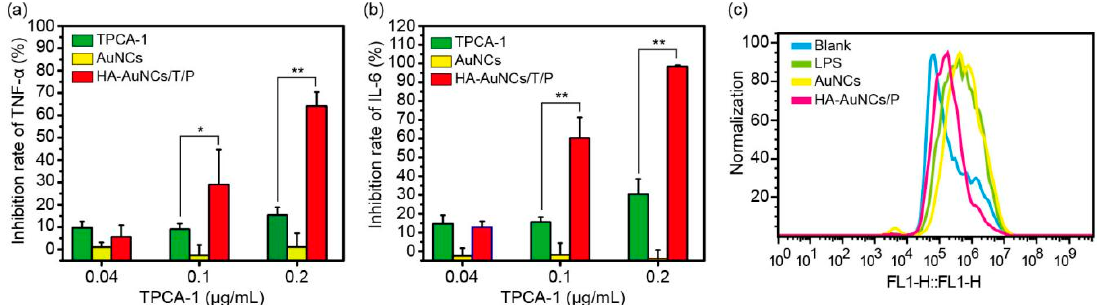
Figure 4. TPCA-1, AuNCs, and HA-AuNCs/T/P inhibit lipopolysaccharide (LPS)-induced ( a ) TNF- α and ( b ) IL-6 production; ( c ) ROS production in RAW 264.7 cells. Data are presented as mean ± SD ( n = 3), * p < 0.05, ** p < 0.01.